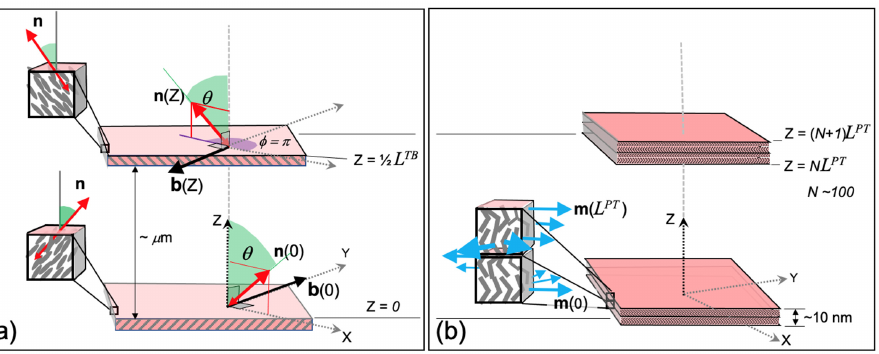
Figure 7. Modulation scales and local molecular ordering in the twist–bend and polar-twisted nematic liquid crystals. Both 1-D modulated phases are partitioned into planar “slabs” stacked perpendicular to the modulation direction (coincident with the Z -axis) and of sufficient thickness to define the local director(s). ( a ) The twist–bend nematic N TB has a 1-D elastic modulation of n twisting about Z with pitch L TB (~ μ m ) ; the varying azimuthal angle φ ( Z ) is defined by the projection of n ( Z ) in the X - Y plane; within each slab n ( Z ) has a uniform direction and maintains a constant projection (cos θ ) on Z . ( b ) The “director” of the polar twisted nematic N PT is the vector m (a C 2 -axis); it has a uniform polar orientation within sub-planes constituting each slab; m ( Z ) undergoes roto- translations about the Z -axis on a nanoscopic scale exhibiting a 1-D modulation pitch L PT (~10 nm). In both ( a ) and ( b ) the cuboid inset dimensions are ~5 nm on edge, large enough to enable the local identifications of n and m ; linear “monomer” and bent-core dimer molecules are indicated by idealized average shapes in the cuboid insets. The N TB and N PT models share two common features: (i) both phases are positionally disordered (no density modulation, i.e., the phases are nematic) and (ii) both present a 1- D modulation of the orientational order, and this introduces a fundamental wave number k . However, the respective values for this wave number, Β k and k , differ by orders of T PT magnitude, reflecting the obvious fact that the corresponding modulations stem from entirely different physical mechanisms. It is precisely for this reason that the wave numbers show, in addition to their vastly different magnitudes, markedly different variations with the thermodynamic parameters as depicted in Figures 3b and 5a. The main differences between the N PT and the N TB models are summarized in Table 1. It is apparent from Figure 7 and Table 1 that the structures of the N TB and N PT are mutually exclusive, leaving no room for physical consistency in descriptions which arbitrarily combine features from both macro- and microscopic regimes to produce hybrid interpretations. Table 1. Physical characteristics that differentiate the N TB model from the N TP model. General Aspects